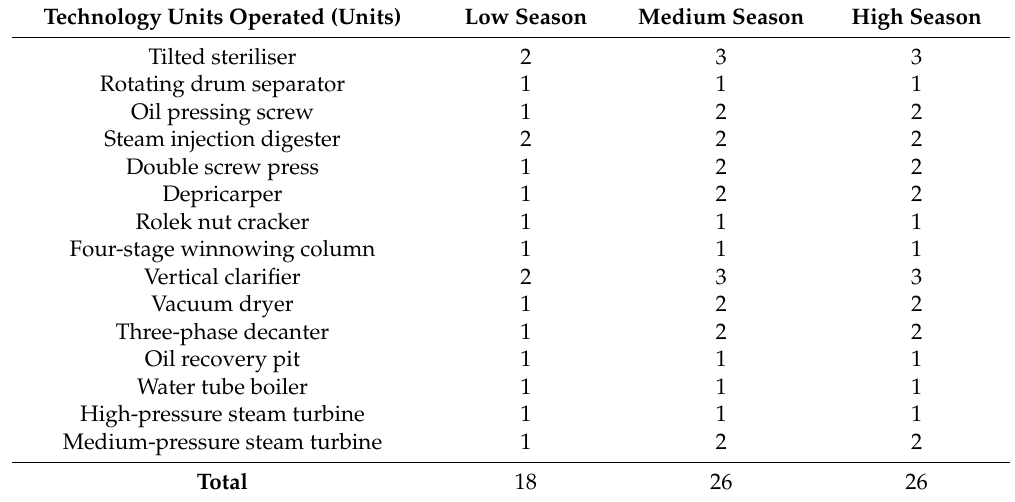
Table 9. Technology units operated for optimised POM design.